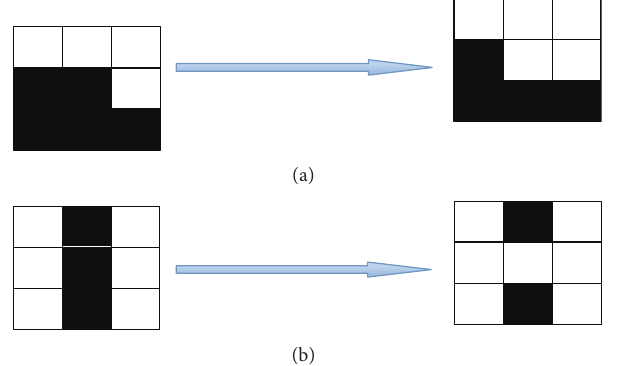
Figure 5: Two examples of flipping center pixel in 3 ∗ 3 window pattern, and (a) has better visual quality than (b) when flipping by using Wu’s method.